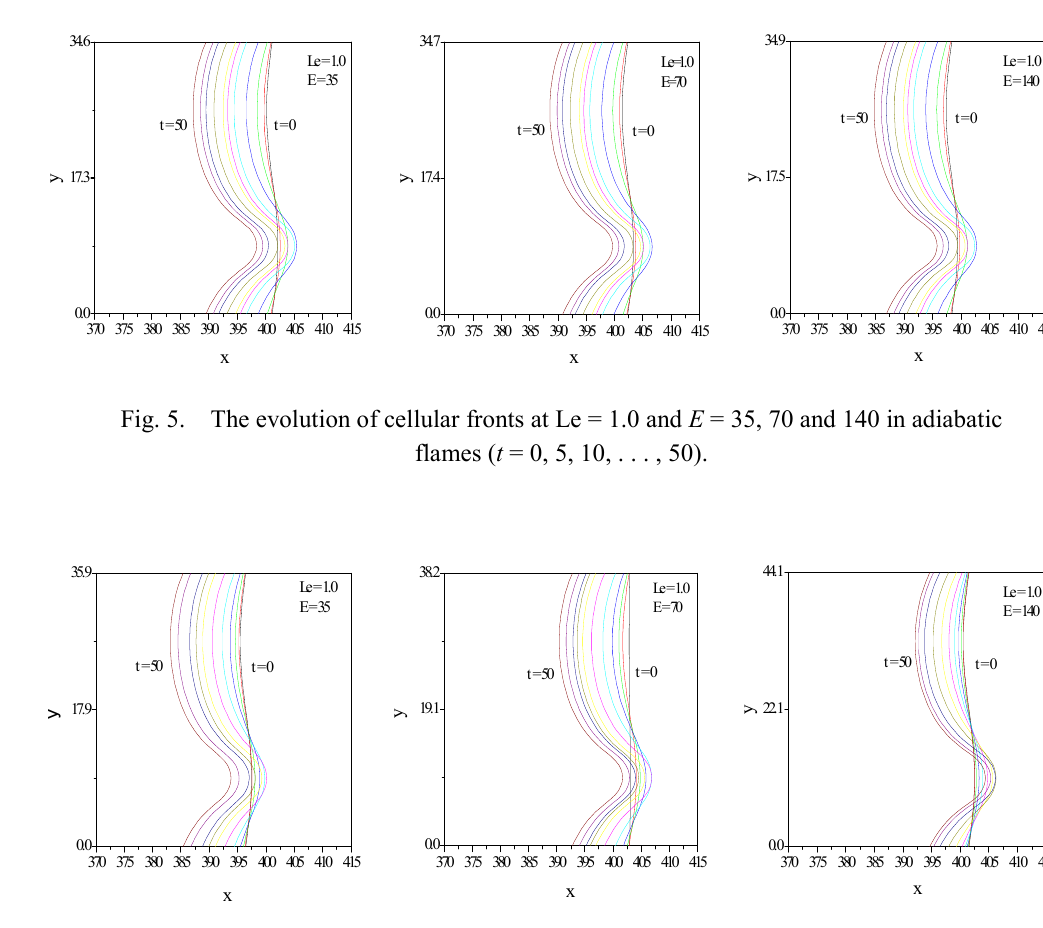
Fig. 6. The evolution of cellular fronts at Le = 1.0 and E = 35, 70 and 140 in non-adiabatic flames ( t = 0, 5, 10, . . . ,